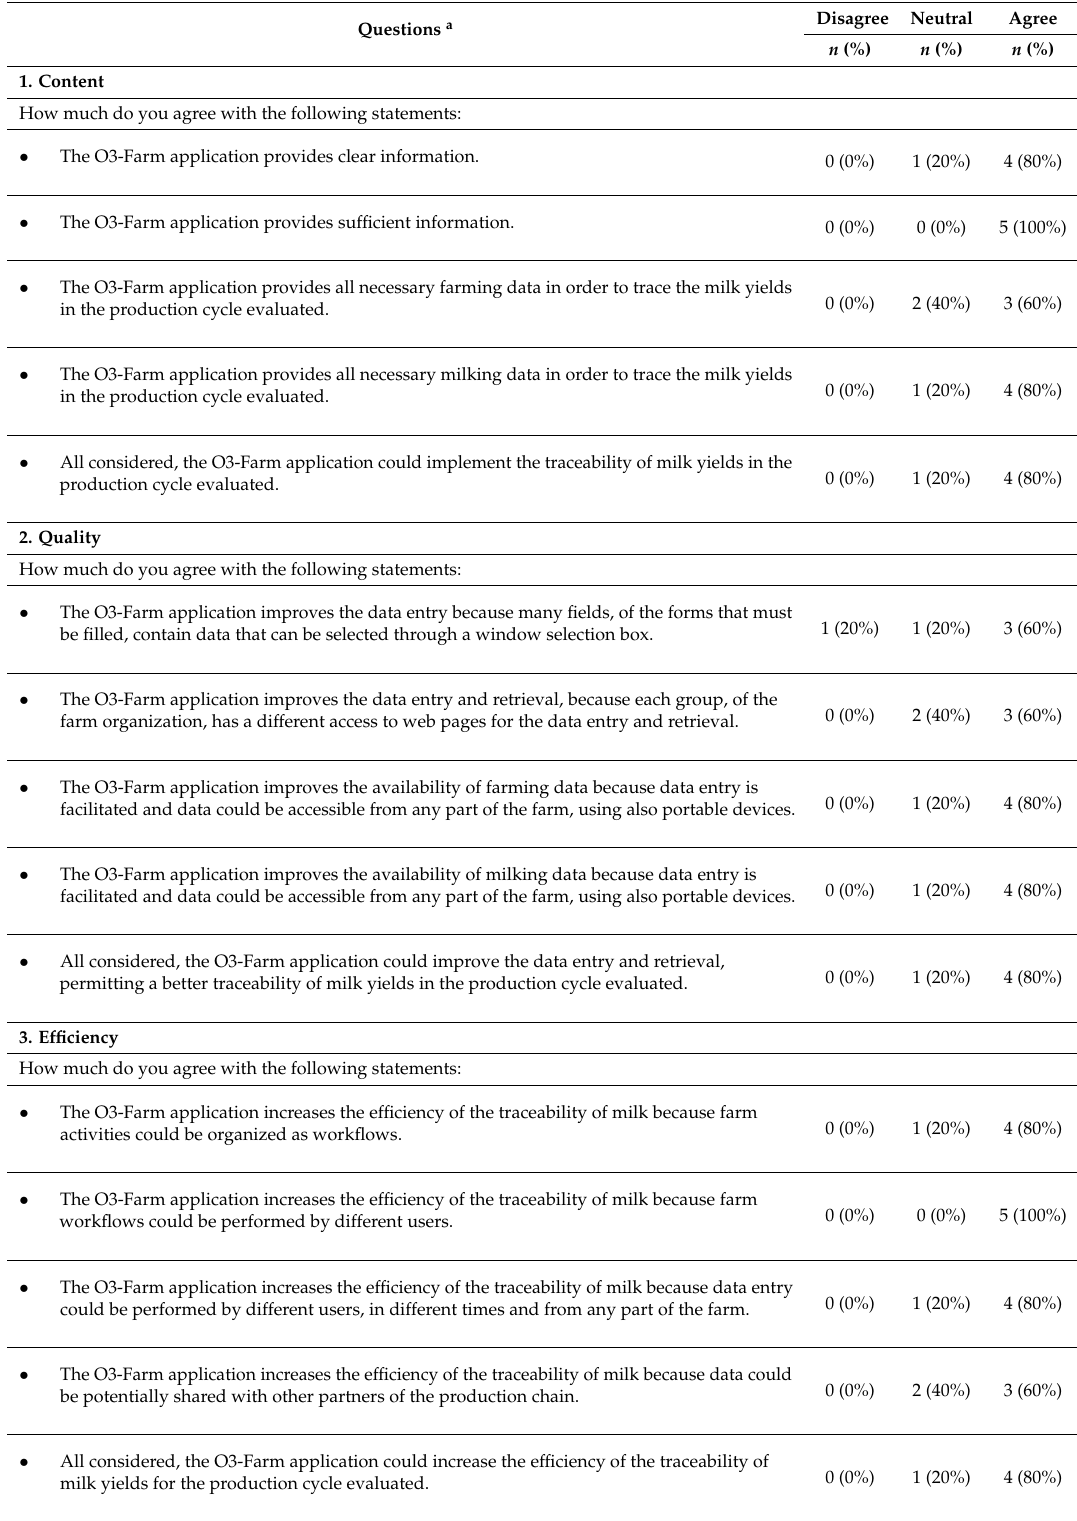
Table 1. Results of the survey performed at the end of a testing phase of the O3-Farm application carried out on a group of five professional farmers. Questions a